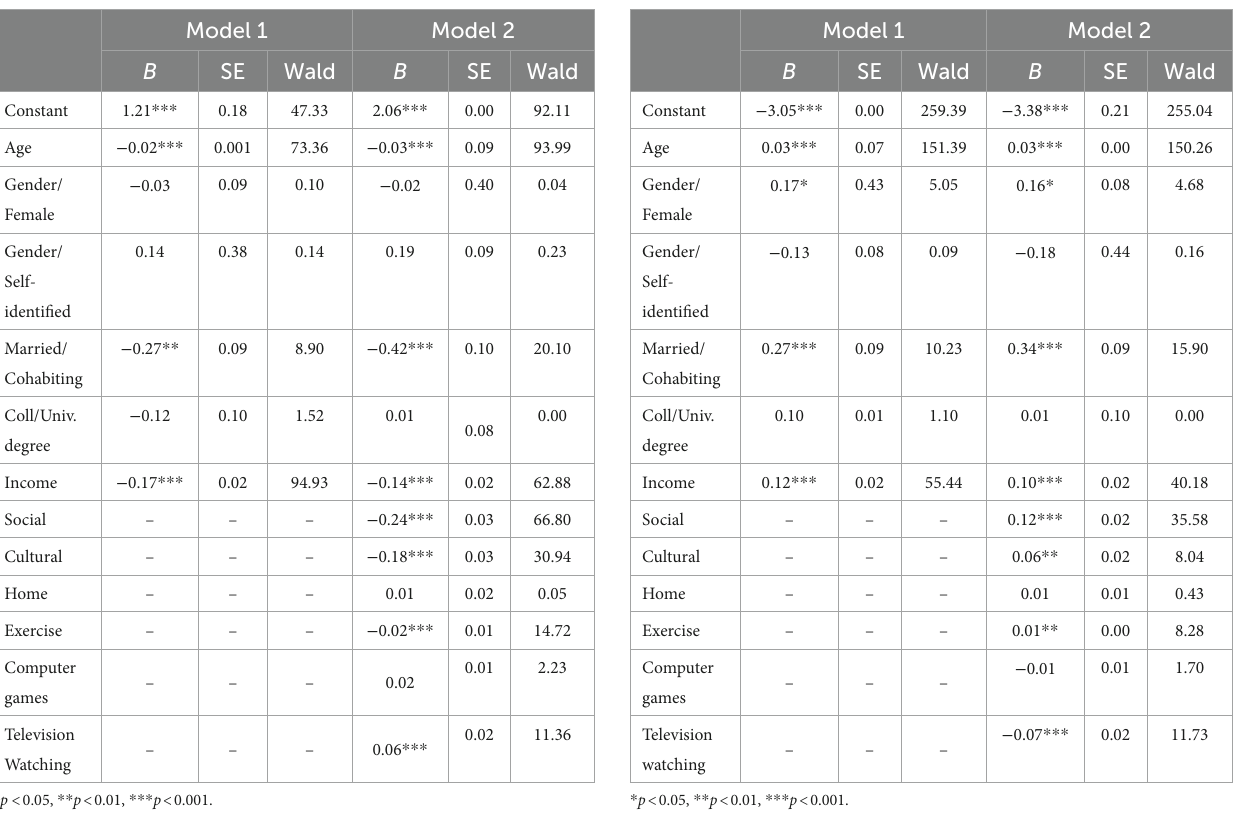
TABLE 4 Binary logistic regression models showing the association of demographic characteristics and leisure activity participation with flourishing (vs. moderate health and